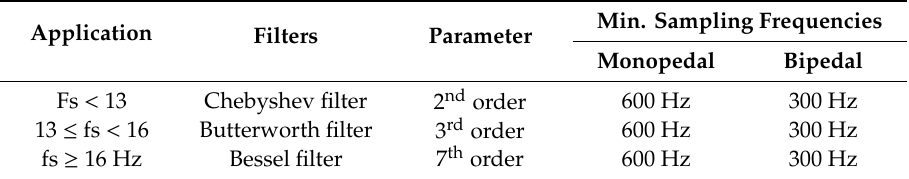
Table 2. Compilation of various use cases for filtering CoP